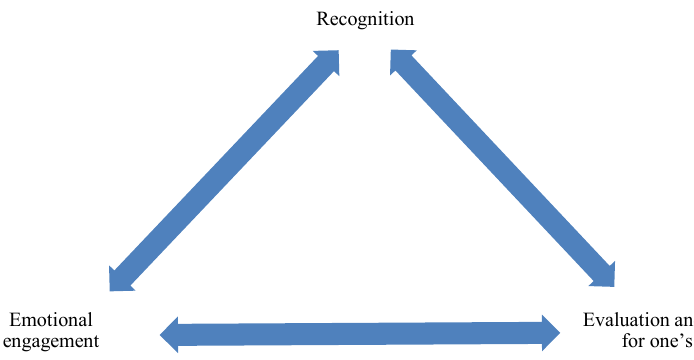
Figure 1. The knowledge triad. The arrows in the figure indicate that each of the three aspects are dependent on each other